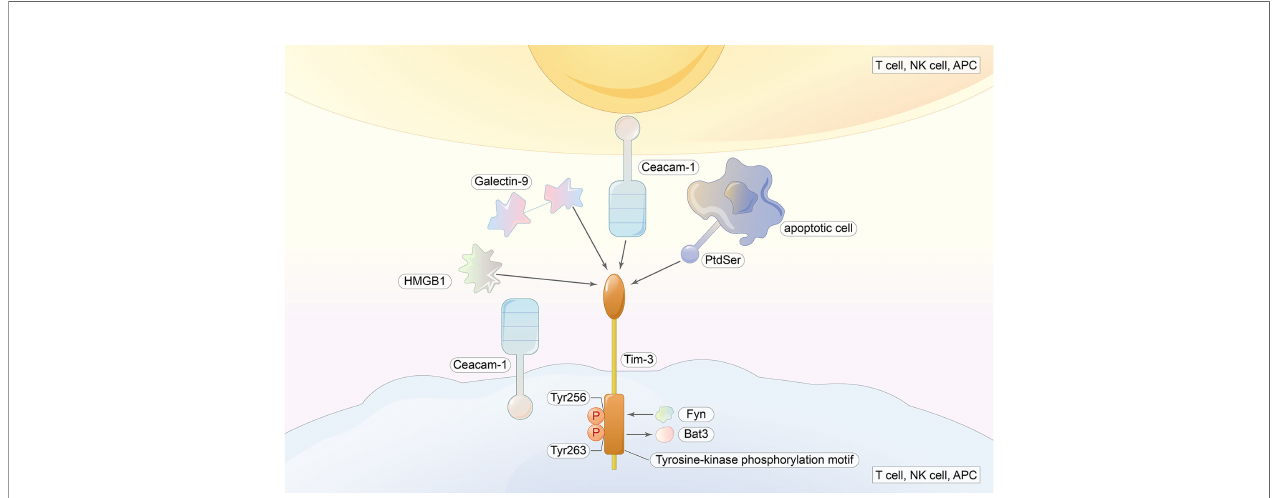
FIGURE 3 | TIM-3 ligands include galectin-9, HMGB1, Ceacam-1, and PtdSer. Ligand binding induces the phosphorylation of Tyr256 and Tyr263 as well as the release of Bat3 from the tail, and Fyn will bind to the same region; thus, the inhibitory function is